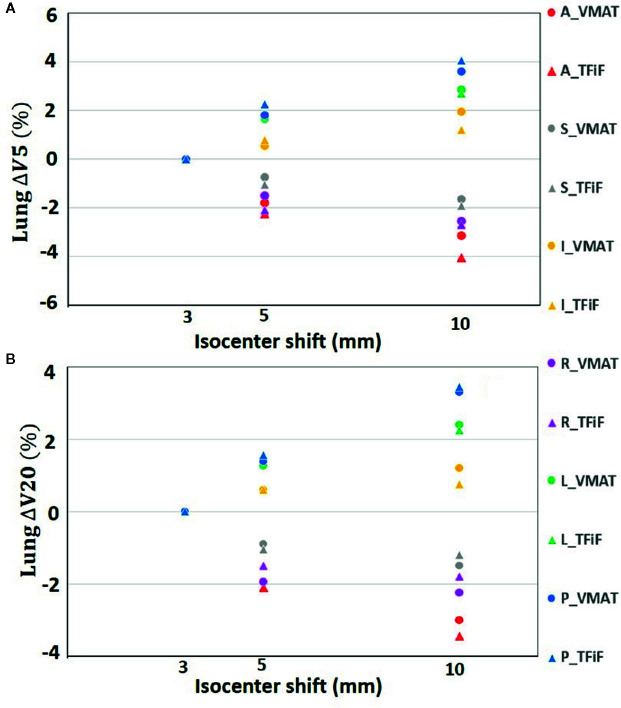
Left lung V5
(A), and V20
(B) absolute difference between VMAT and TFiF references and corresponding perturbed plans, for different isocenter shifts directions and magnitude. VMAT, volumetric modulated arc therapy; TFiF, tangential field in field; ant, anterior; sup, superior; inf, inferior; post, posterior.